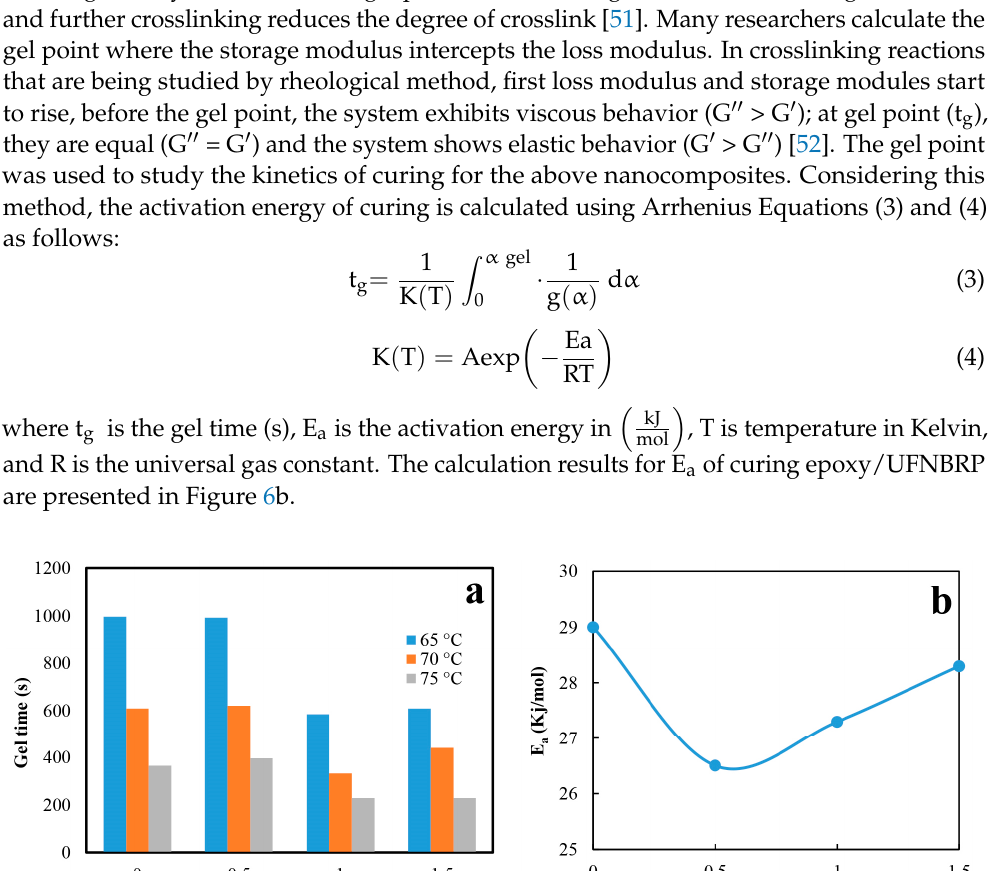
Figure 5. The complex viscosity versus time at different temperatures of 65, 70 and 75 °C for ( a ) epoxy resin, ( b ) epoxy resin/0.5% UFNBRP ( c ) epoxy resin/1% UFNBRP and ( d ) epoxy resin/1.5% UFNBRP.